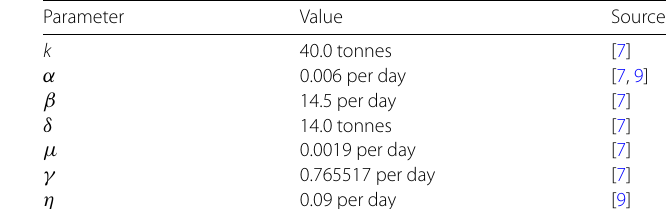
Table 1 Estimation for values of the parameters